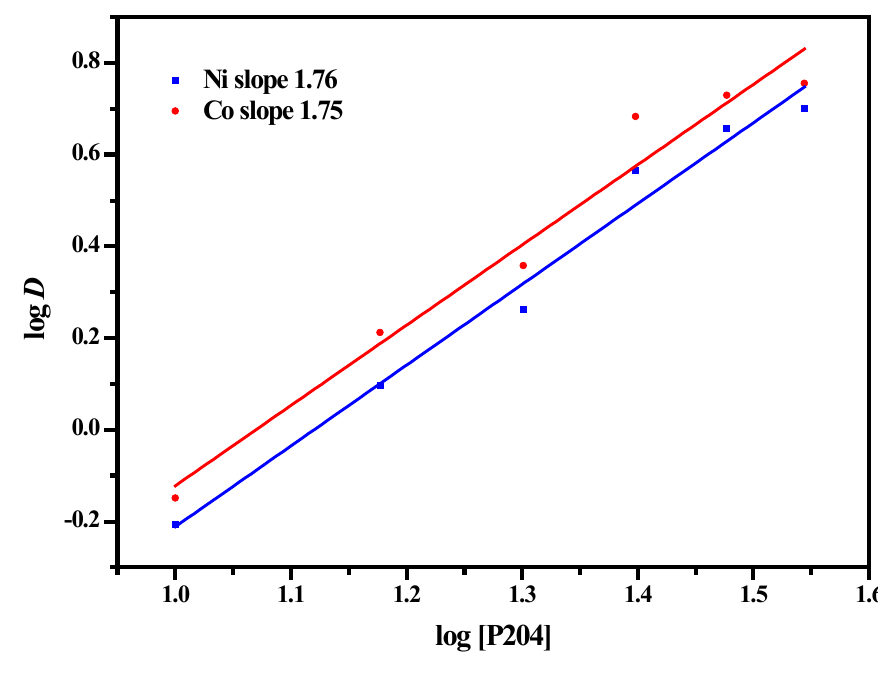
Figure 11. log D —log[P204] diagram of Ni and Co.